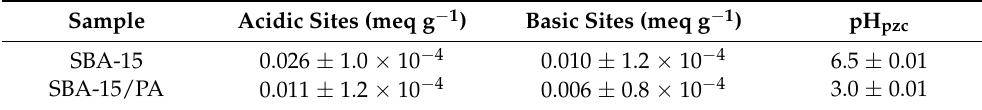
Table 2. Acidity, basicity, and pH at zero charge point of SBA-15 and its modification.